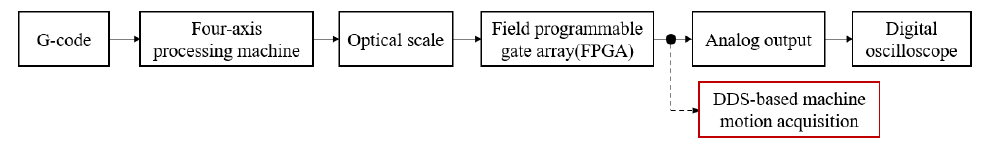
Figure 1. Sensing process of the motion displacement for a legacy machine tool.